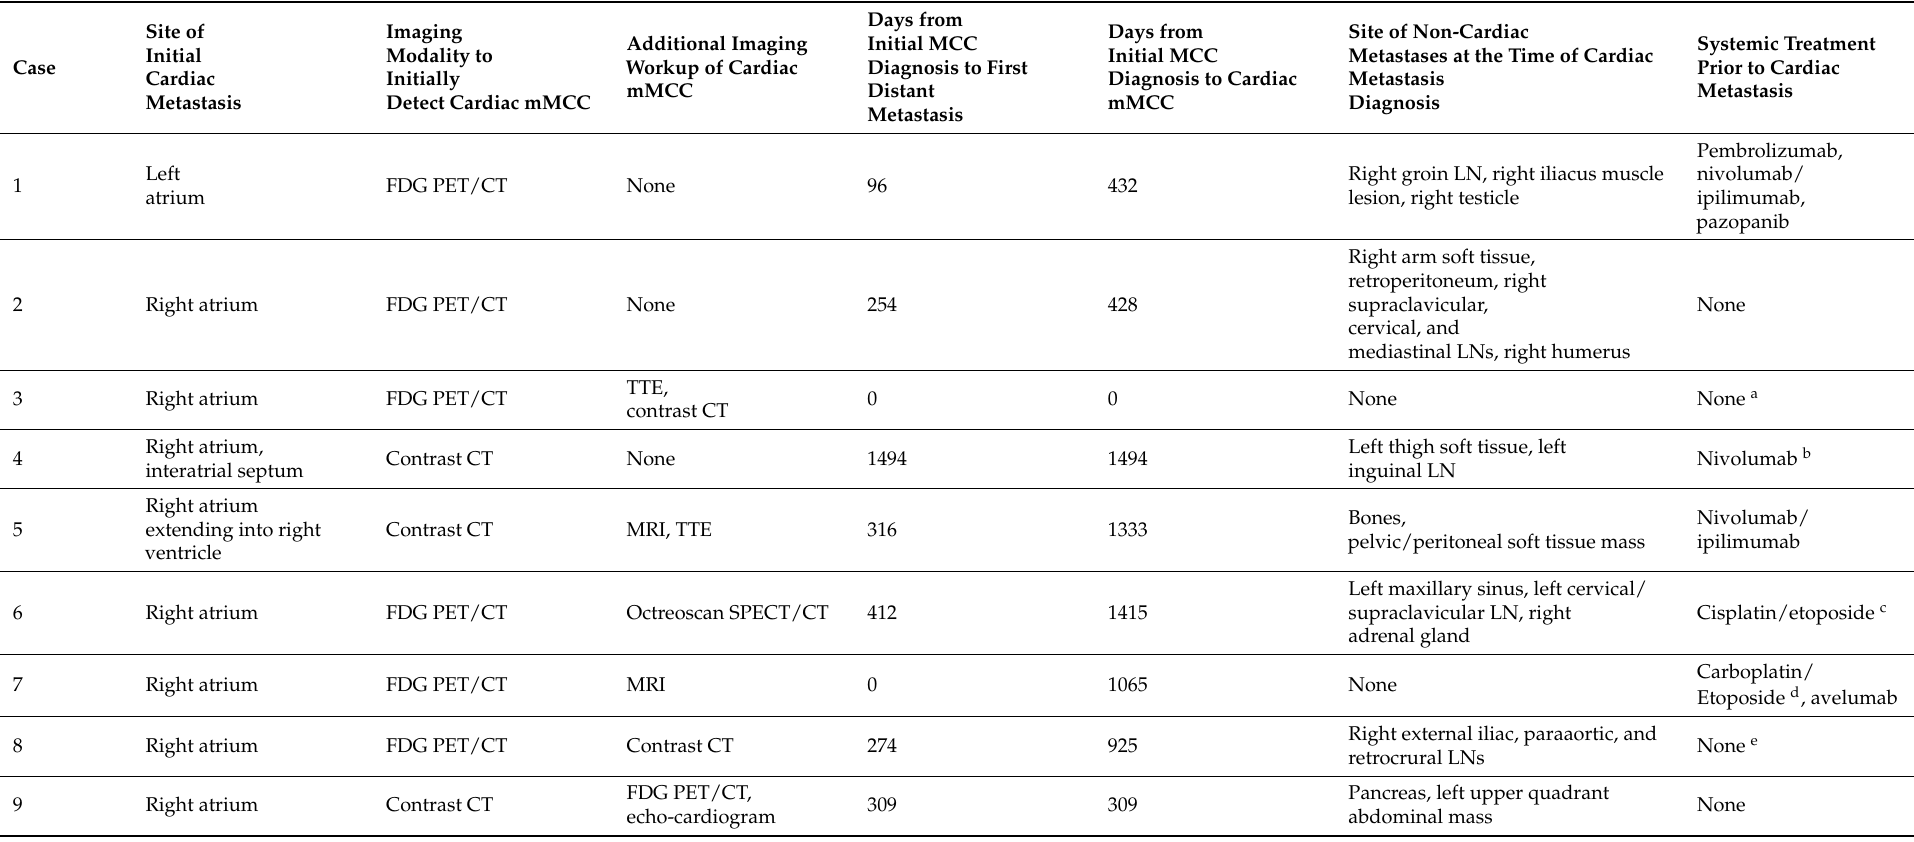
Table 2. Imaging details and timing of cardiac metastatic